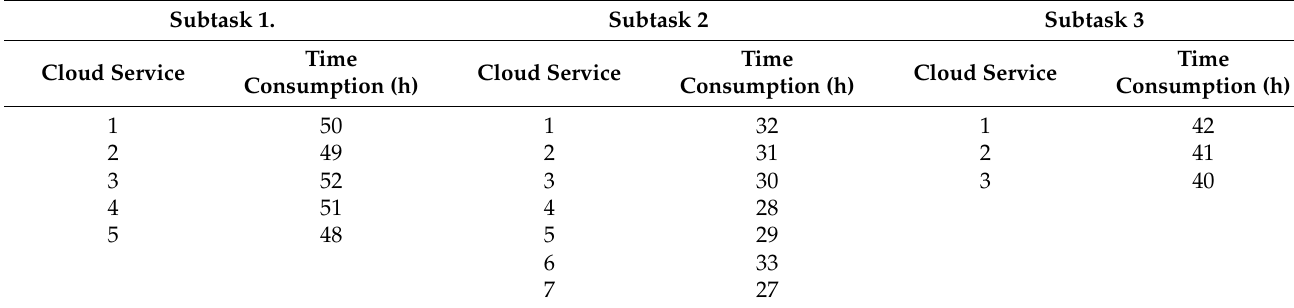
Table 2. The handover time consumption between No.1 and No.2 subtask module